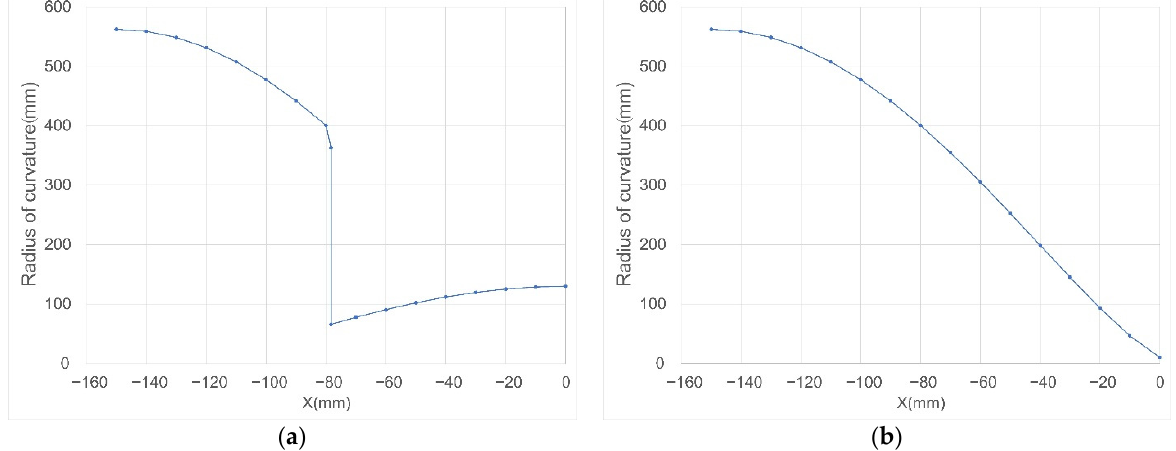
Figure 9. Radius of curvature: ( a ) Upper surface; ( b ) Lower surface. Table 1. Boundary condition.